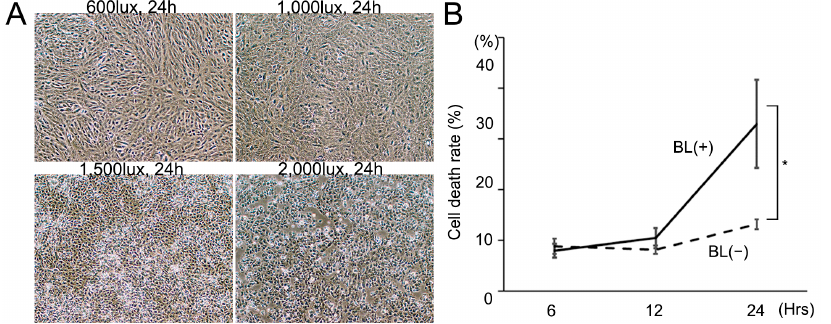
Figure 1. Cell death was enhanced by increasing blue-light (BL) intensity and irradiation time. ( A ) BL exposure increased the cell death rate in an intensity-dependent manner after 24 h exposure. ( B ) The cell death rate was significantly higher with BL 1500 lux exposure than that without BL exposure 24 h later (* p = 0.0094; n = 4 per group). Statistical analysis was performed using one-way ANOVA, followed by Tukey’s multiple comparisons test where